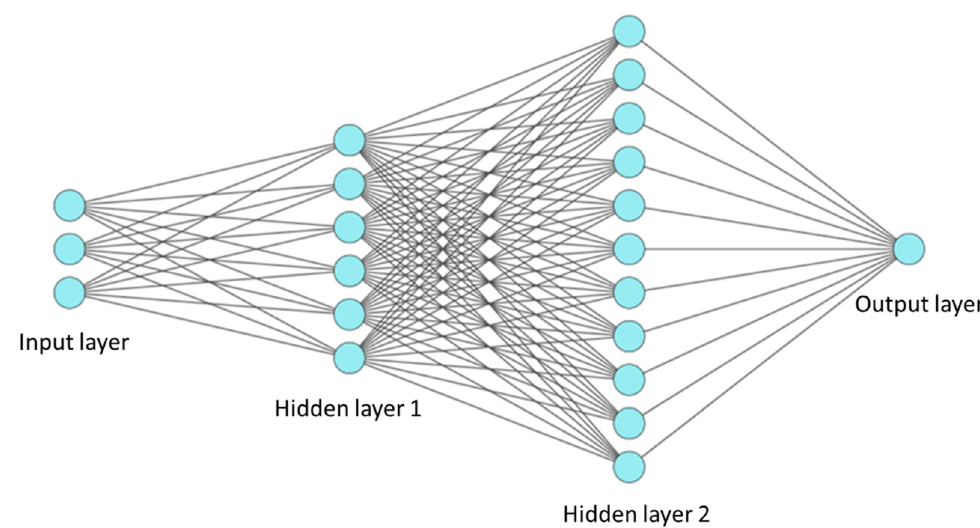
Figure 2. The ANN architecture: Input layer (15 neurons); Hidden layer 1 (100 neurons, followed with Leaky ReLU);